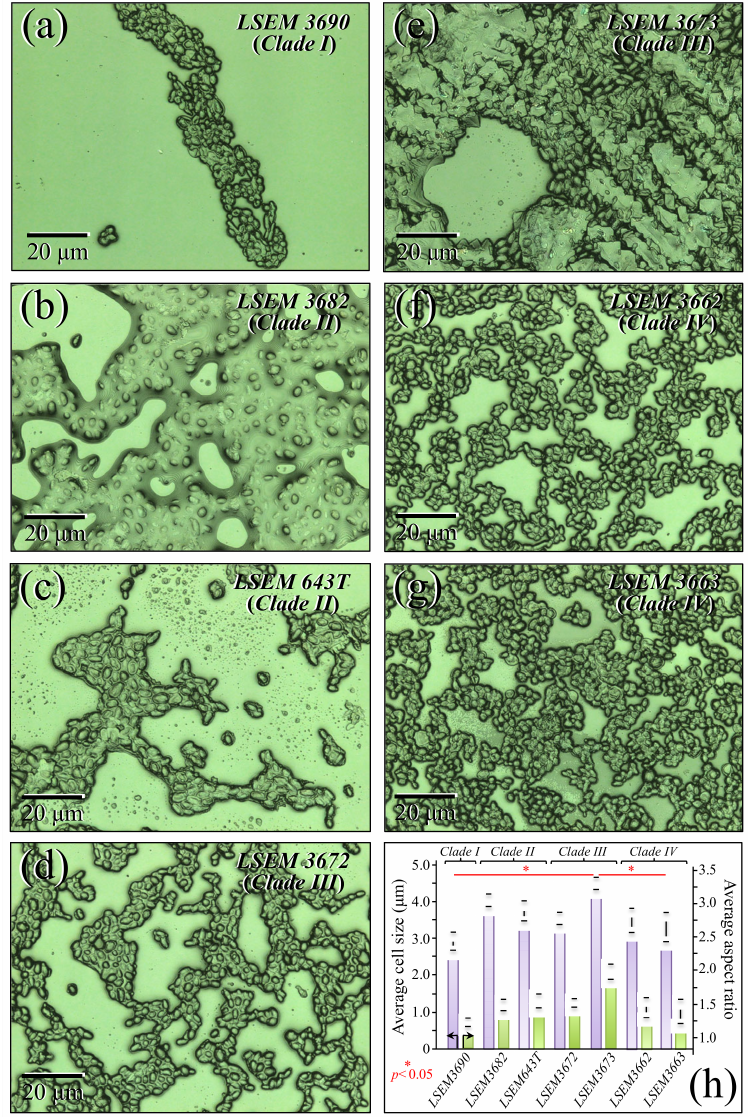
Figure 1. ( a – g ) Laser micrographs of the seven investigated clades/subclades of C. auris (four clades in total with related subclades; cf. labels in inset); ( h ) average cell size and aspect ratio as directly measured on the respective micrographs are shown with their respective standard deviations (statistically relevant differences according to statistical t -test validations with significance set at p < 0.05 and labeled with one asterisk; cf. labels in